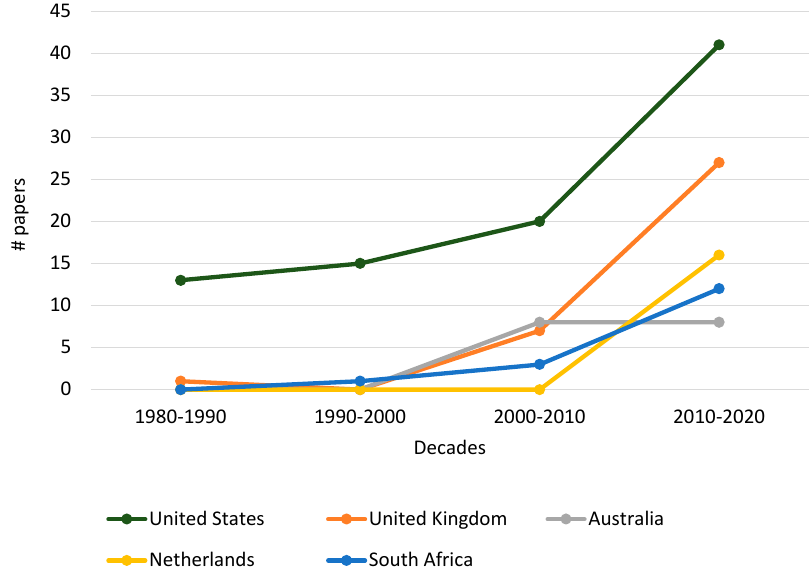
Figure 3. Number of papers published by decade in the United States, the United Kingdom, Australia, the Netherlands, and South Africa.